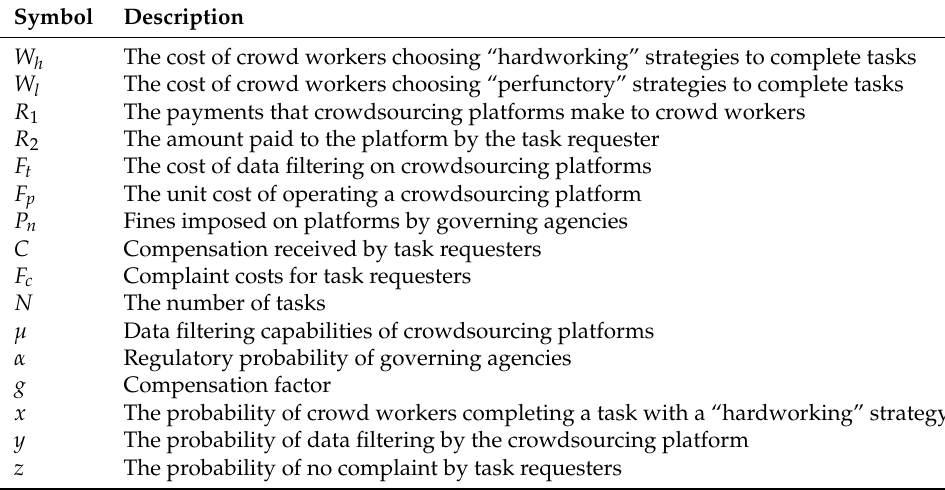
Table 1. Main symbols used in the